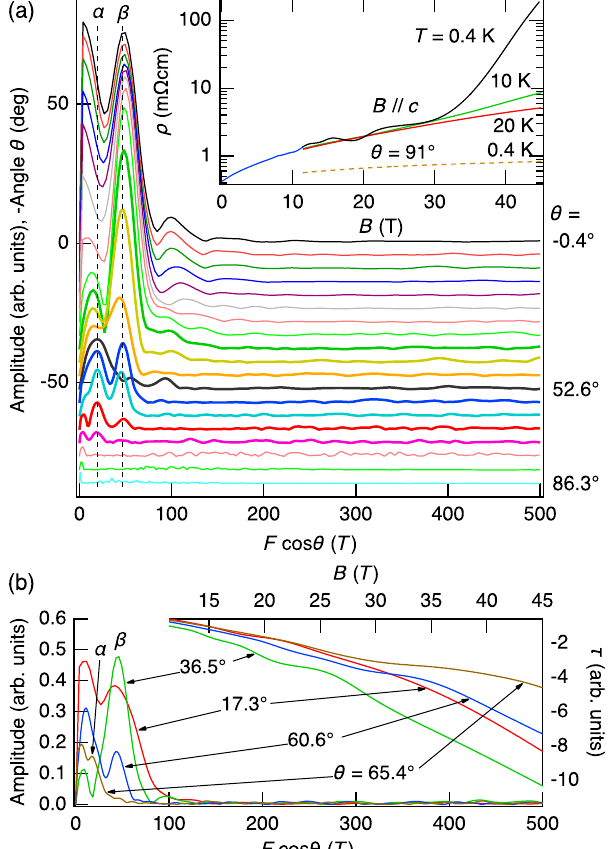
FIG. 5. (a) Oscillatory part of the resistivity as a function of 1 = ð B cos θ Þ for field directions near θ ¼ 52 . 6 °. All the curves are from the hybrid measurements. (b) Oscillatory part of the resistivity as a function of 1 = ð B cos θ Þ after box smoothing. The box (window) size is the same as one oscillation period of the β frequency, and hence the β oscillation is effectively removed. The curves for θ ¼ 0 , 28.3, and 48.3° are from the 20-T measurements, while the others from the hybrid